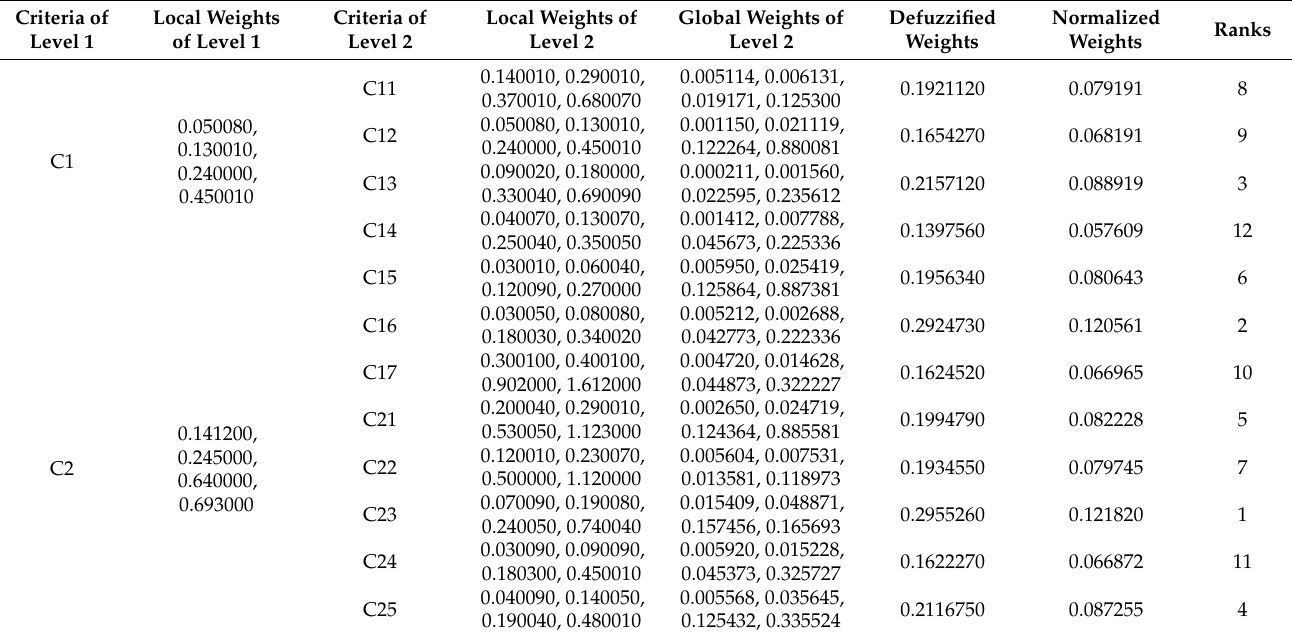
Table 5. Final Weights through the